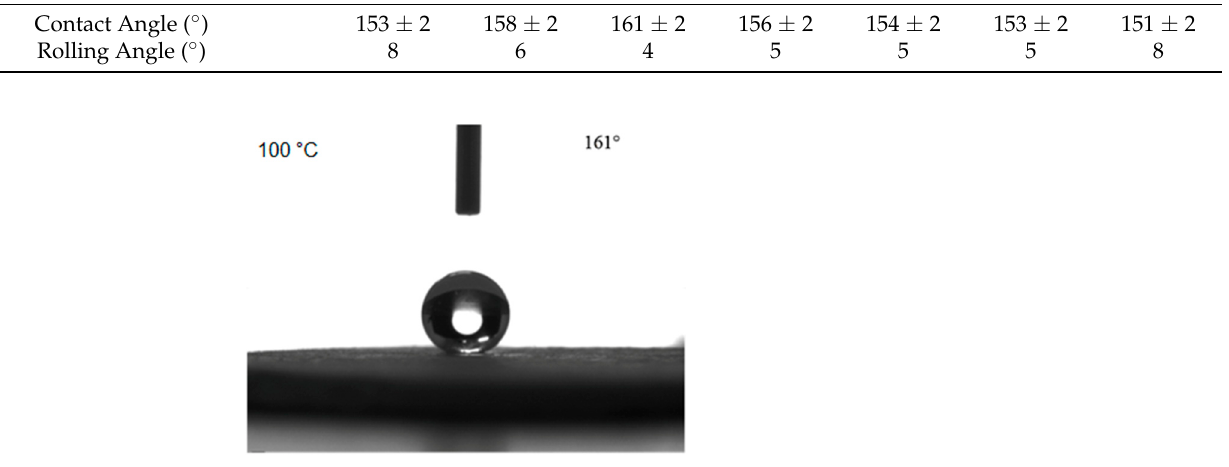
Figure 7. TG-DTG curve of the superhydrophobic bulk material.